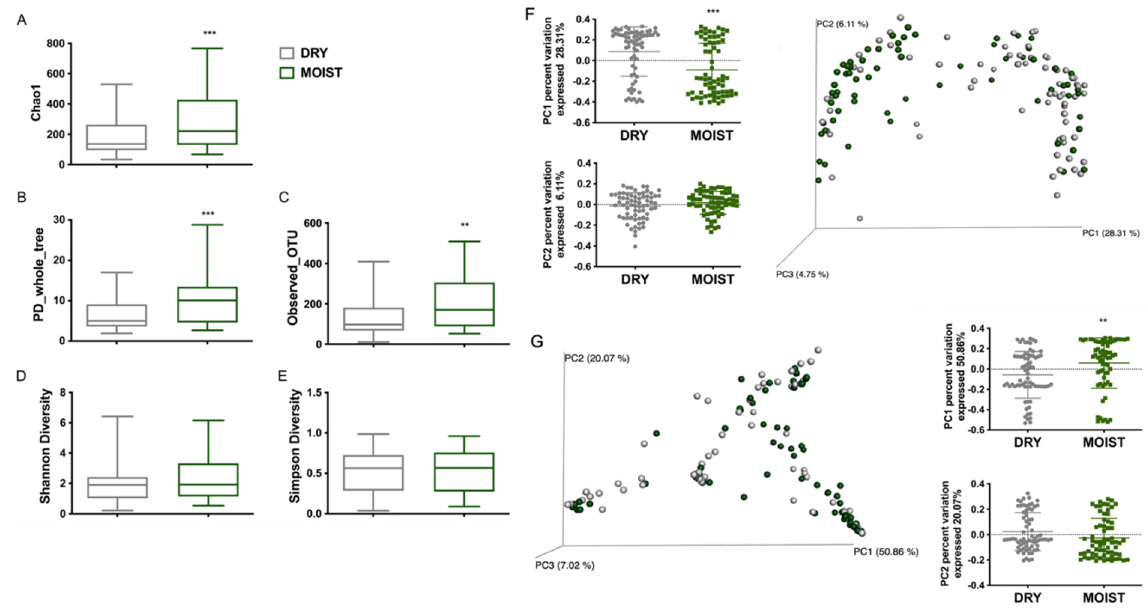
Figure 2. Comparison of the microbiota associated with skin-type and gender. ( A , C ) Phylum level. ( B , D – F ) genus level. Data were analyzed with unpaired parametric t-test comparing moist and dry group * p < 0.05, ** p < 0.01, *** p < 0.001 and comparing male and female # p < 0.05, ## p < 0.01, ### p < 0.001.